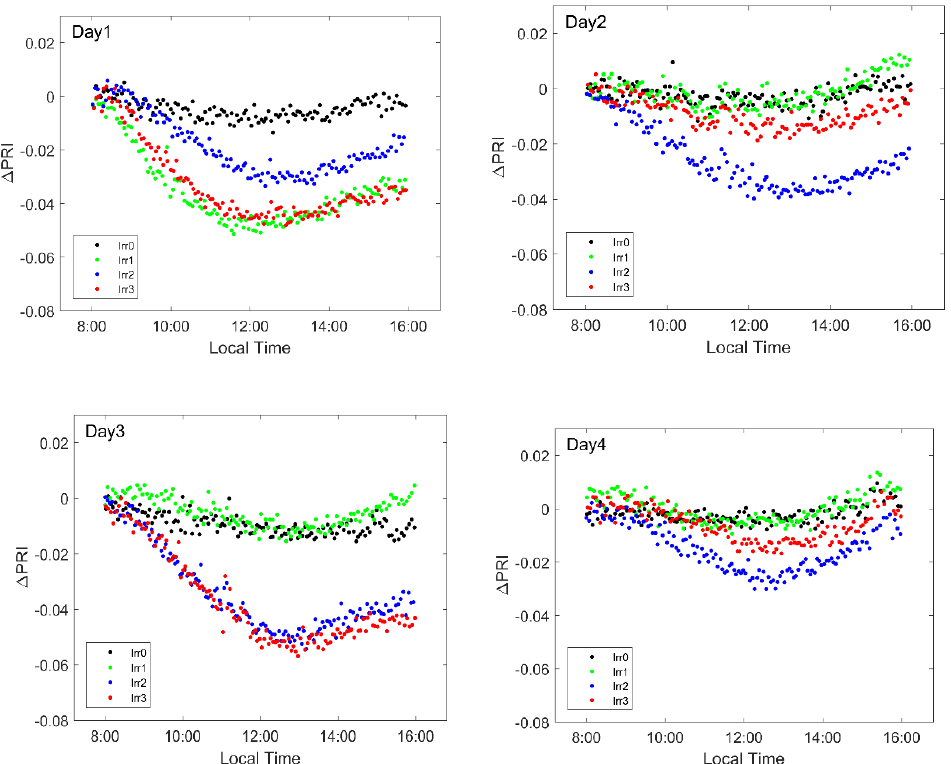
Figure 4. Diurnal ∆ PRI during experiment, with Day1 to Day4 representing the 4 observation dates (30 July, 31 July, 3 August, 4 August). On the evening of Day1, Irr1 and Irr3 were watered 0.3 m 3 and 0.16 m 3 , respectively. On the evening of Day3, Irr0, Irr1, Irr2 and Irr3 were watered 0.4 m 3 , 0.2 m 3 , 0.3 m 3 and 0.16 m 3 , respectively.